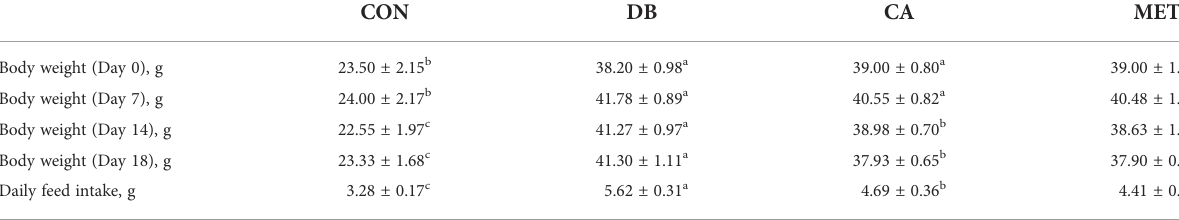
TABLE 1 Effects of chlorogenic acid on body weight and feed intake in db/db